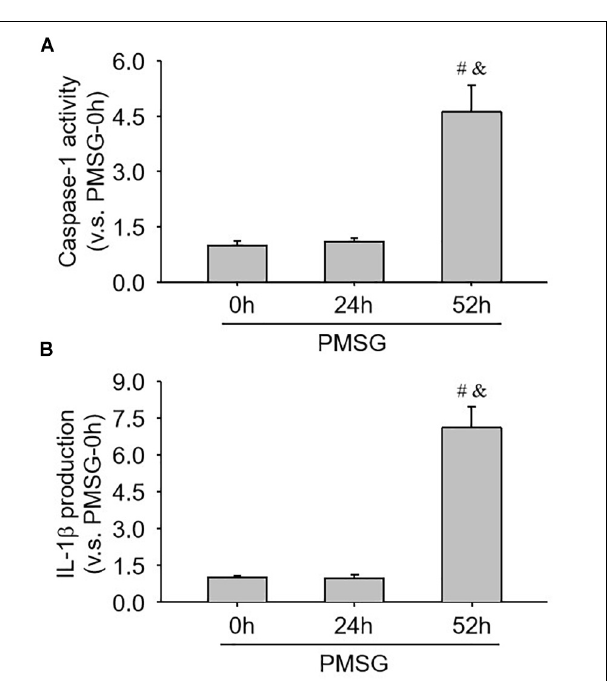
FIGURE 7 | Examination of caspase-1 activity and IL-1 β production in the ovary during the follicular development induced by PMSG. (A) The data for caspase-1 activity in the ovaries from each group normalized to the control (PMSG-0 h). (B) The data for IL-1 β production in the ovaries from each group normalized to the control (PMSG-0 h). Each value represents the mean ± SE. One-way analysis of variance (ANOVA) was used to analyze the data, followed by a Tukey’s multiple range test. n = 6. # P < 0.05, vs. PMSH-0 h; & P < 0.05, vs. PMSH-24